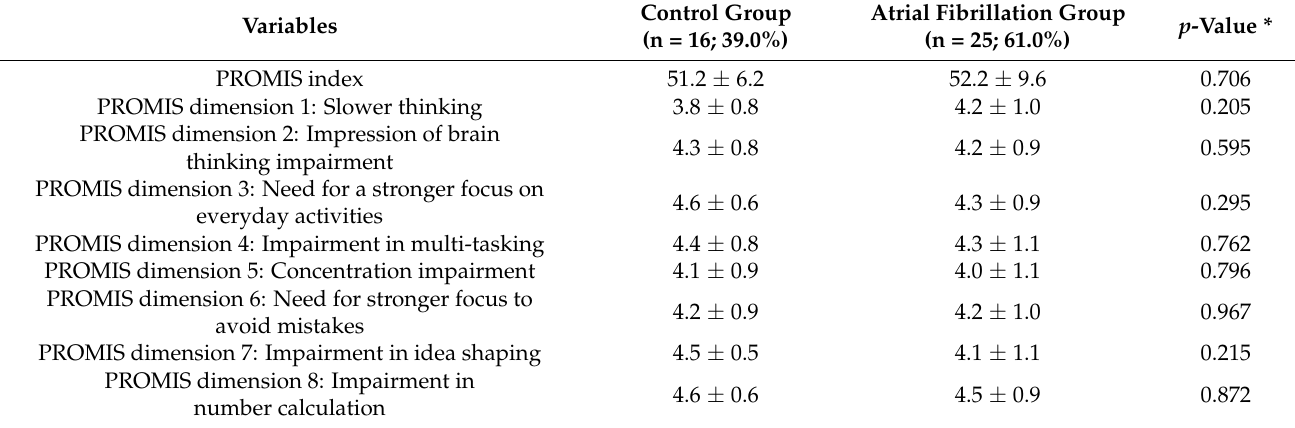
Table 3. Comparison of cognitive function scores between the study